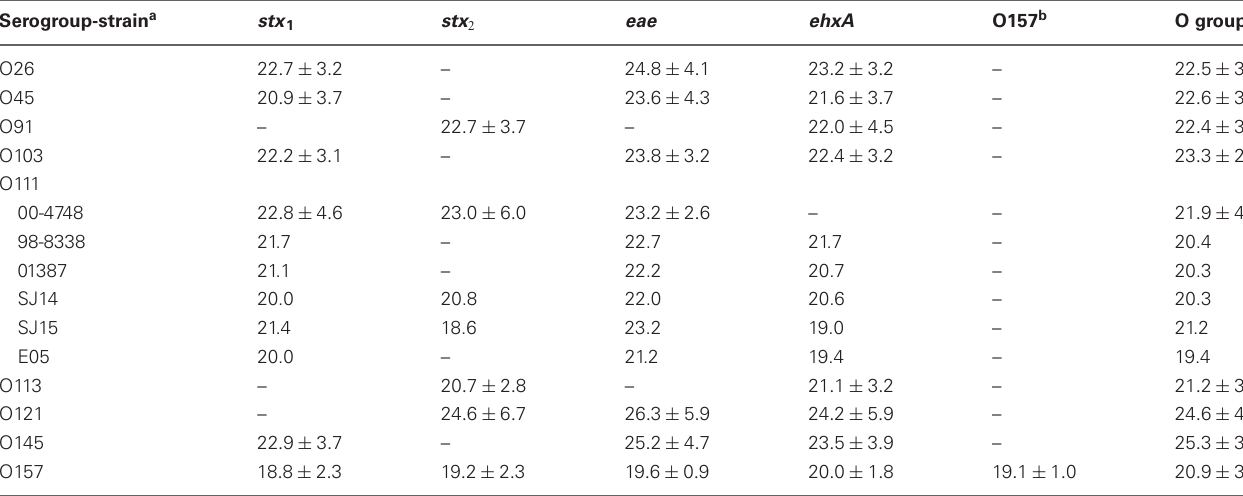
Table 3 | Average cycle thresholds ± STDEV of GeneDisc assays using BPW for enrichment of ground beef samples. Serogroup-strain a stx 1 stx 2 eae ehxA O157 b O group b